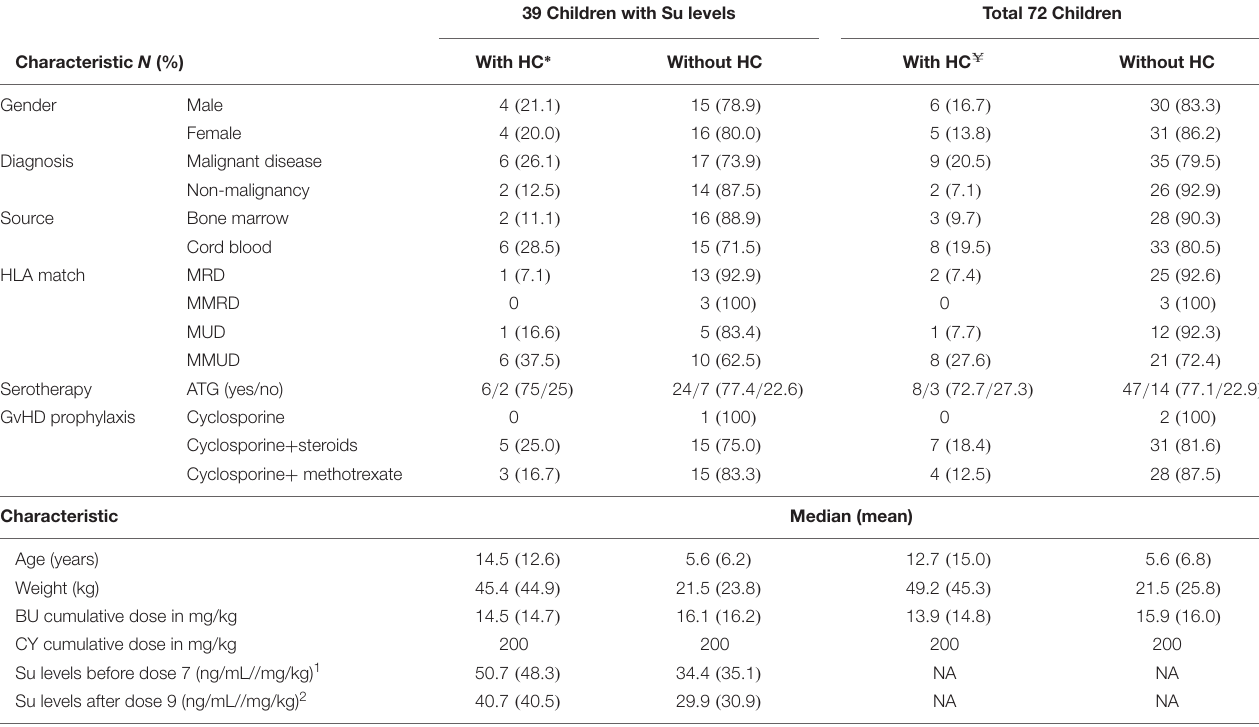
TABLE 2 | Demographic and transplant characteristics of the patients included in the study.